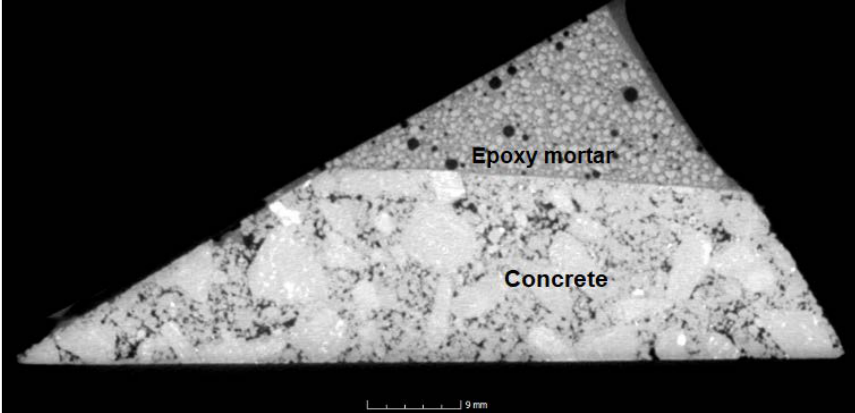
Figure 22. CT scan of the corner reprofiled by the reference epoxy composite.